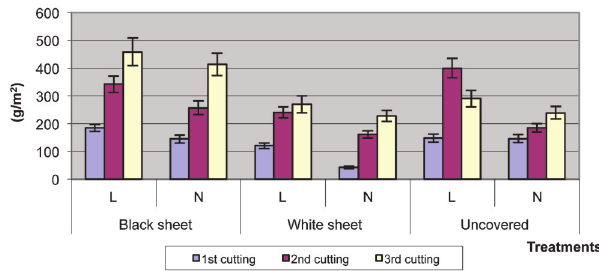
Figure 2. Evaluation of raw weight (g/m 2 ) by different treatments